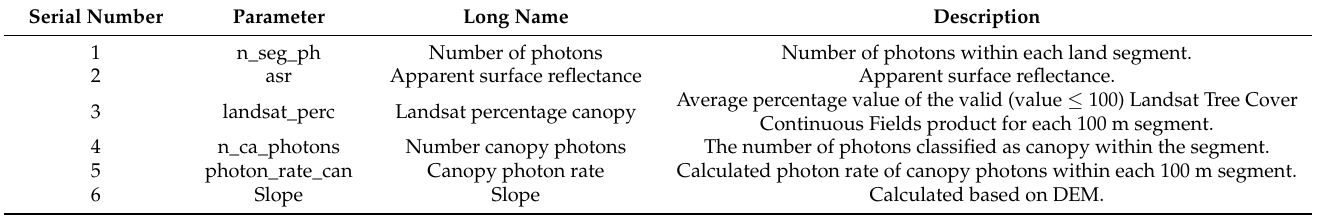
Table 4. Parameter definitions for significant correlation with AGB.